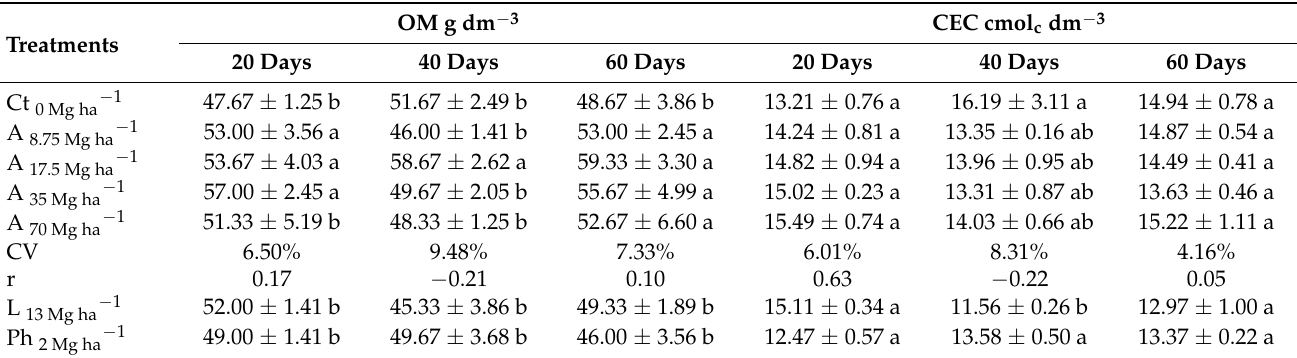
Table 6. Chemical attributes of Yellow Latosol as a function of the application of ash from Amazonian biomasses, lime, and phosphate fertilizer. Mean values and standard deviations of the organic matter (OM) content and cation exchange capacity (CEC) obtained after the three incubation